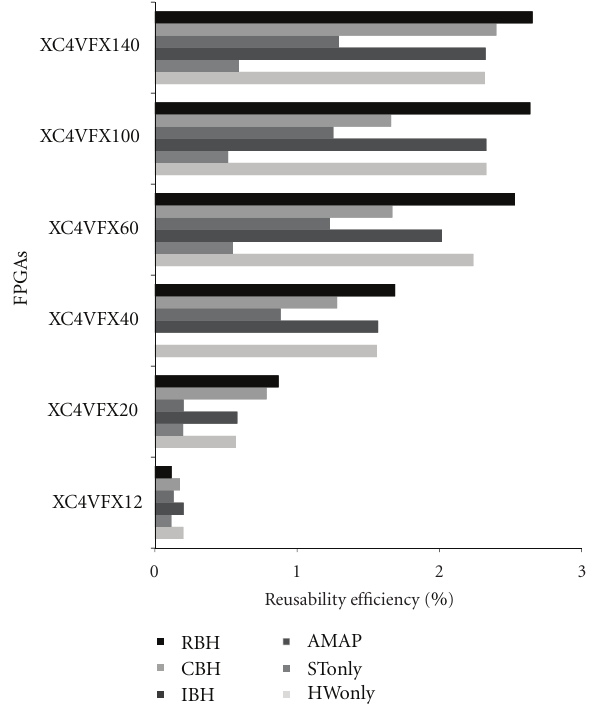
Figure 10: Heuristics comparison under di ff erent FPGAs condi- tions in terms of application reusability e ffi ciency (RE app ). RBH has better RE app compared to other